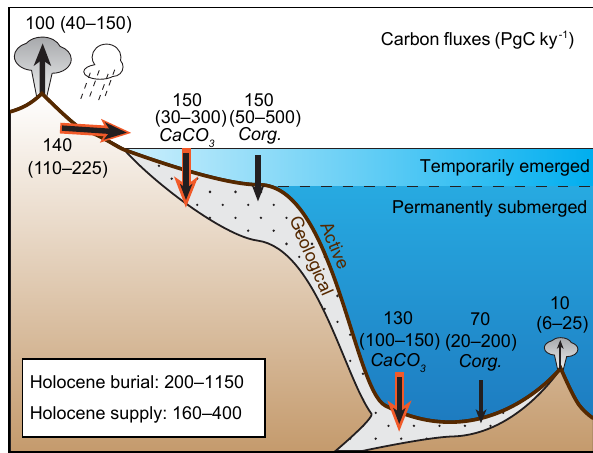
Figure 1. Estimated modern global transfers of carbon between the geological and active inventories. Here, “active” refers to car- bon in the ocean, atmosphere, and terrestrial biosphere, including peatland and permafrost. Sea level variations on glacial–interglacial timescales distinguish two fundamentally different domains of seafloor on which carbon burial has occurred: surfaces fringing the continents that emerged as ice sheets grew, and the permanently submerged surfaces of continental slopes and the deep sea. As dis- cussed in Sect. 2, the modern fluxes are highly uncertain. Ranges in parentheses show the values found in the literature, above which representative modal values are shown. The total carbon inventory in the pre-industrial ocean, atmosphere, and biosphere is estimated to have been ∼ 41000PgC, 93% of which was located in the ocean (Hain et al., 2014). Red arrows highlight fluxes that remove or sup- ply alkalinity to the ocean, in addition to